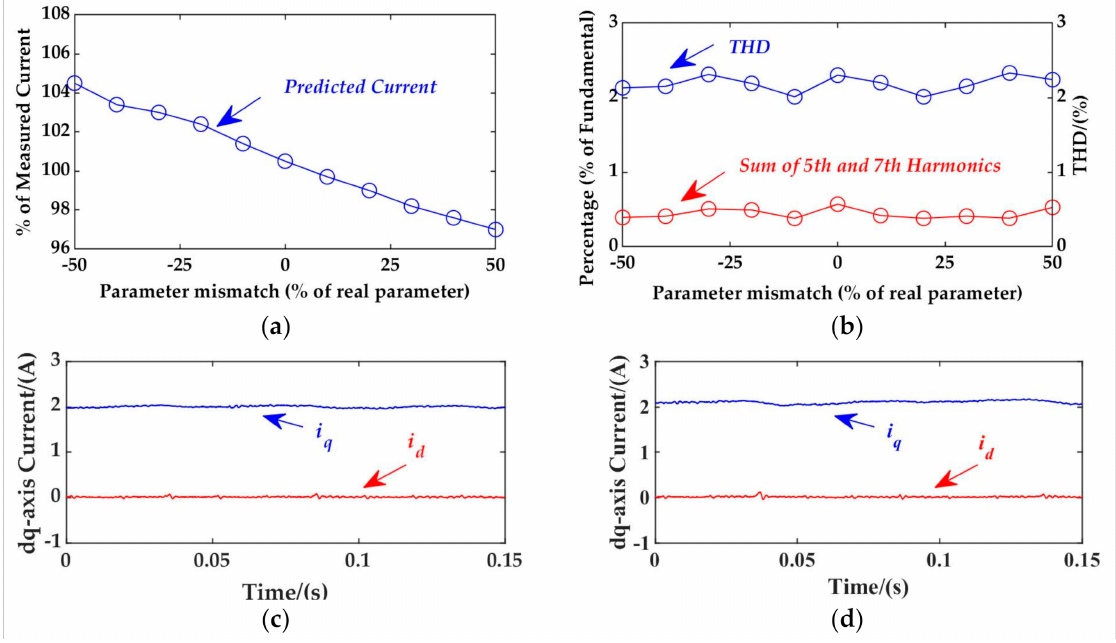
Figure 19. Test results under mismatched stator winding resistance. ( a ) Ratio of percentage of predicted current versus measured current. ( b ) THD, 5th and 7th harmonics of phase A current. ( c ) dq –axis currents under − 50% stator winding resistance error. ( d ) dq –axis currents under 50% stator winding resistance